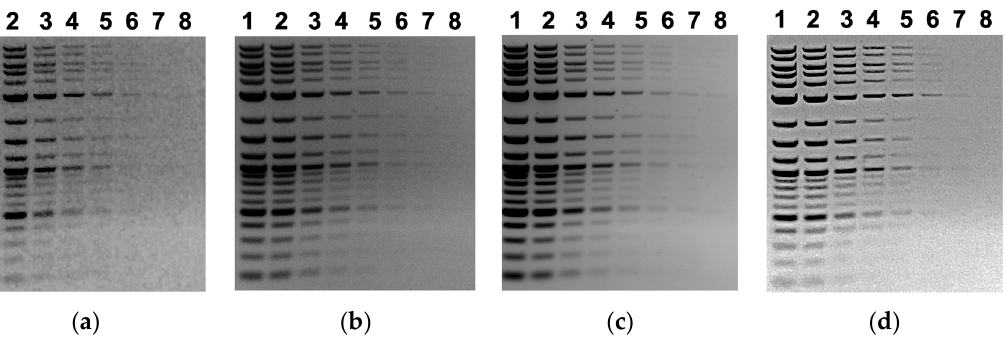
Figure 6. Comparison of images obtained from our repurposed documentation system and other gel documentation system packages. The images are photographs of the same gel obtained using ( a ) our system, using a repurposed 5 MP iPad Air; ( b ) using an AlphaImager EP (Alpha Innotech, ~$2000 USD used); ( c ) Azure Biosystem C400 ($41,000 USD new from VWR); and ( d ) using our system and a newer, non-obsolete iPhone 12. A 1:2 dilution series of a DNA molecular weight standard (NE Biolabs 1 kb plus ladder) was loaded on a 1% agarose/TAE gel, with 10 uL loaded per lane and eight samples loaded, as in Table 1. Because of the wide variation in light level capture, each image was processed using Photoshop to produce an image with best visibility of lower concentration bands.